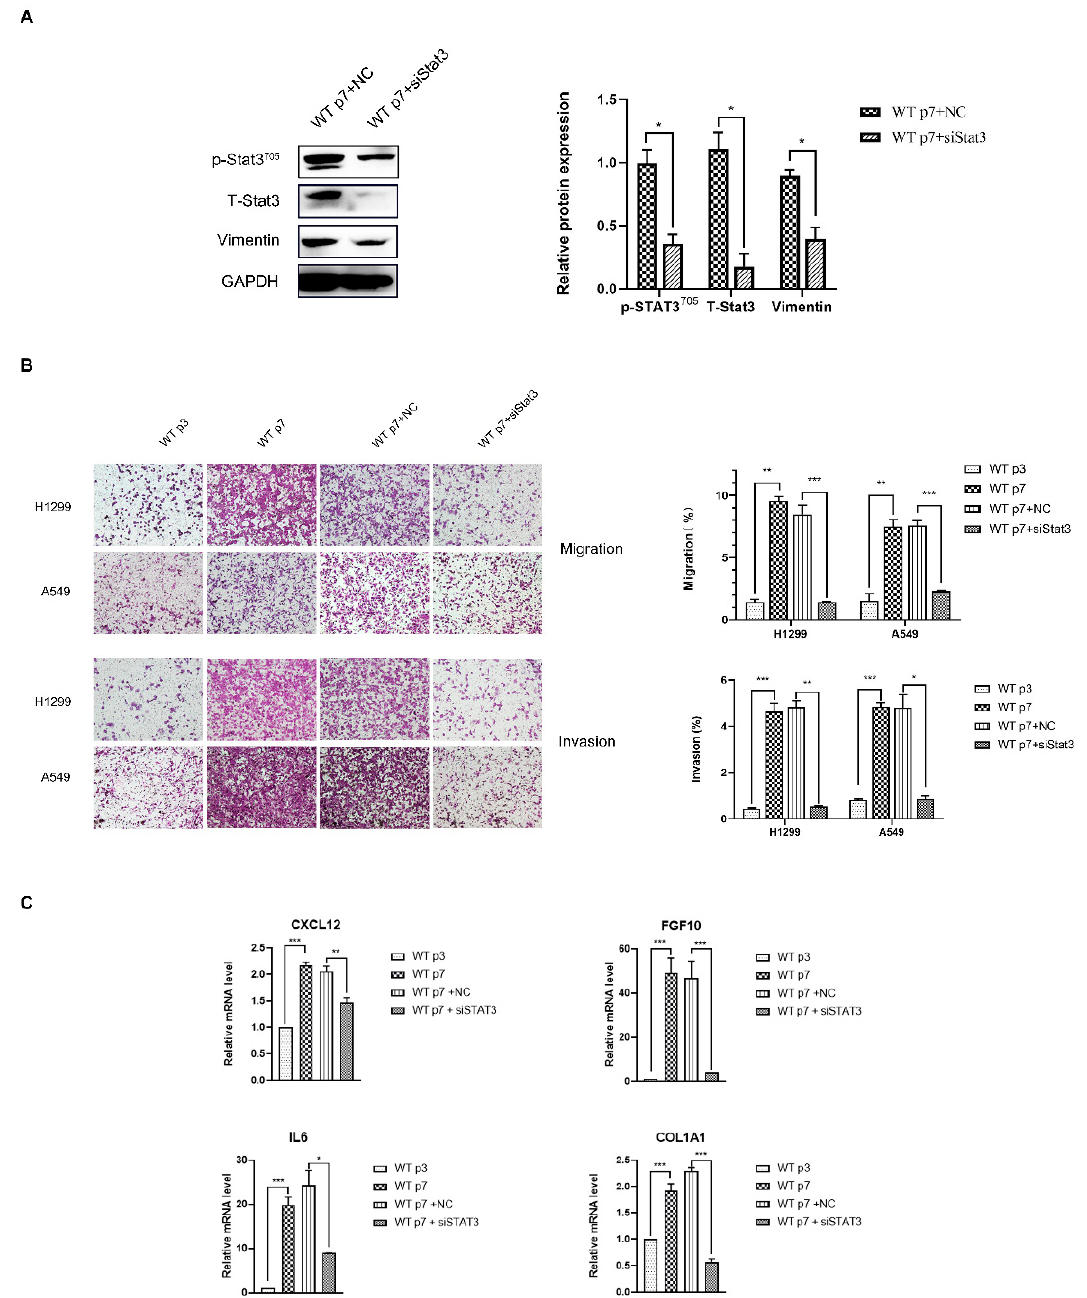
Figure 4. Senescent fibroblasts promote the migration and invasion of lung cancer cells H1299 and A549 through the Stat3 pathway. ( A ). Western blotting analysis of Stat3 and Vimentin expression in senescent fibroblasts and Stat3-transfected senescent fibroblasts. Quantification of the Western blotting and statistical analysis. *, p < 0.05. ( B ). Transwell assays were performed to evaluate the migration and invasion of H1299 and A549, following a co-culture with fibroblasts. An average migration/invasion ± SEM from three independent experiments was performed. Statistical analysis. **, p < 0.01, ***, p < 0.001. ( C ). Quantification of CXCL12, FGF10, IL6 and COL1A1 mRNA from fibroblasts by qRT-PCR. Values (mean ± SEM) were derived from three independent experiments. *, p < 0.05 **, p < 0.01, ***, p < 0.001.